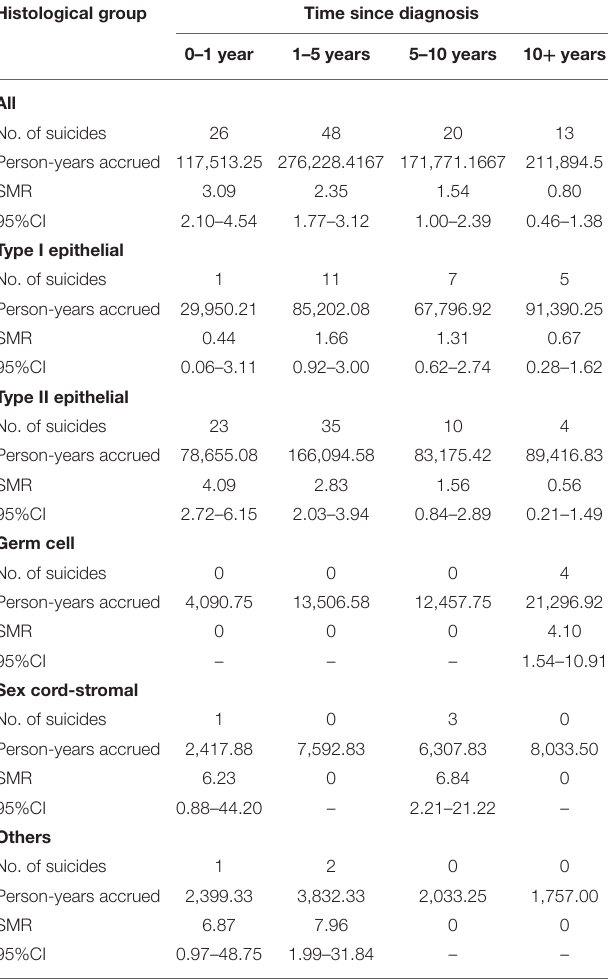
TABLE 5 | The risk of suicide among patients with ovarian cancer by histological group and time since diagnosis. Histological group